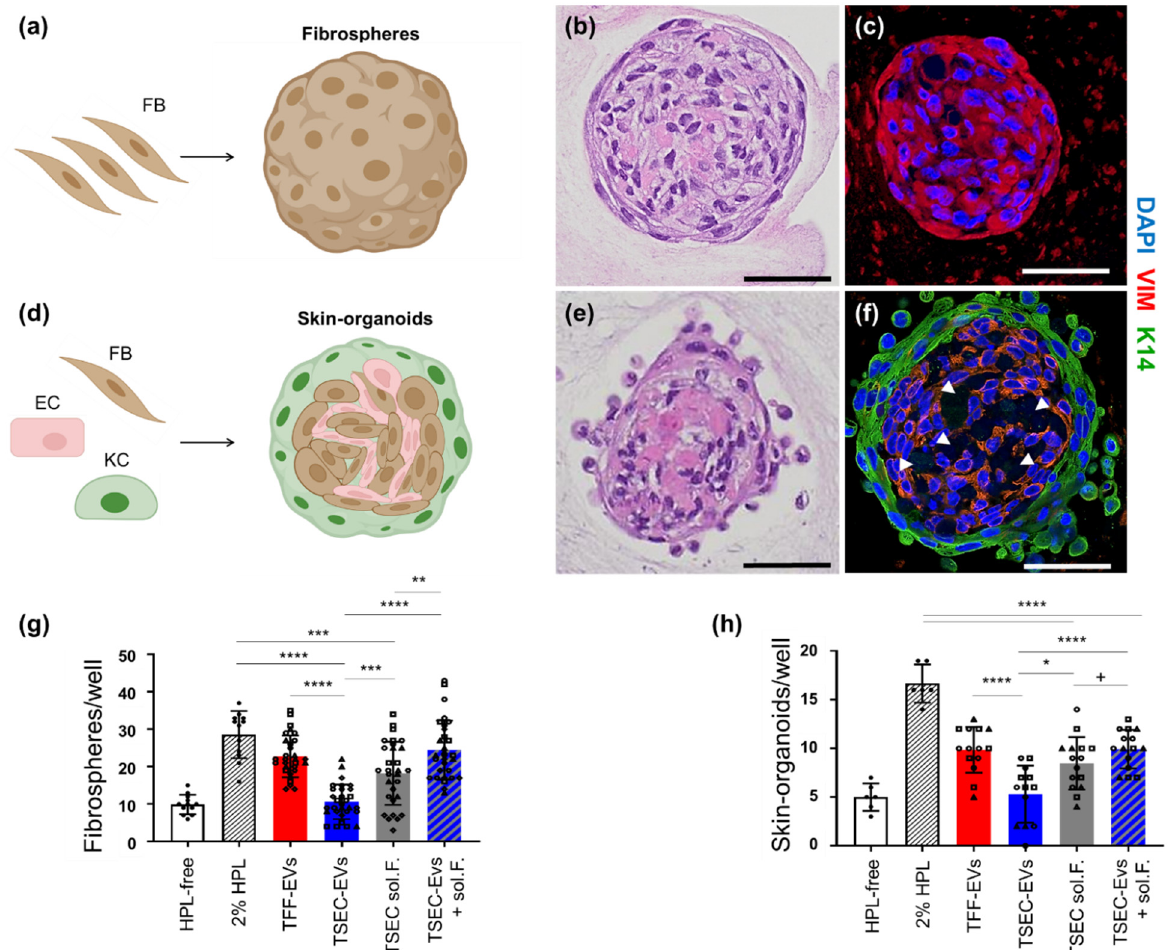
Figure 3. TSEC-EVs enhance fibrosphere and skin-organoid formation in the presence of platelet proteins. ( a – c ) Fibrosphere formation. ( a ) Cartoon illustrating monotypic fibroblast (FB) aggregation. ( b ) Hematoxylin eosin staining and, ( c ) immunostaining of representative fibrospheres showing compact and human vimentin (VIM)-positive structures. ( d – f ) Skin-organoid formation. ( d ) Cartoon illustrating aggregation of primary human FBs, keratinocytes (KCs) and endothelial cells (ECs) when seeded in a 2:1:1 ratio in a permissive environment. ( e ) Hematoxylin and eosin staining of a represen- tative skin organoid presenting a compact core with stratified envelope. ( f ) Immunohistochemistry confirmed a human VIM-positive dermal core with vascular-like empty spaces (white arrow heads) and a surrounding cytokeratin K14-positive KC layer. Scale bars: 50 µ m. Schematic cartoons created using Biorender. ( g ) Quantification of fibrospheres per well was performed after incubation of 10 5 EVs/cell. Matching protein concentrations of TSEC-soluble fractions 19–21 and TSEC-EVs plus their corresponding TSEC-soluble fractions (TSEC-EVs + soluble fractions) after 6 days with 5000 FBs per well ( n = 5). ( h ) 2500 KCs, 1250 FBs and 1250 ECs per well for skin-organoid quantification were analyzed accordingly ( n = 3). Each symbol (circles, squares and triangles) represents a different biological replicate ( n = 5 for fibrosphere assay, n = 3 for skin-organoid assay), each performed in hexaplicates. One-way ANOVA/Tukey, **** p ≤ 0.0001, *** p ≤ 0.001, ** p ≤ 0.01, * p ≤ 0.05; + p ≤ 0.05; one-tailed t